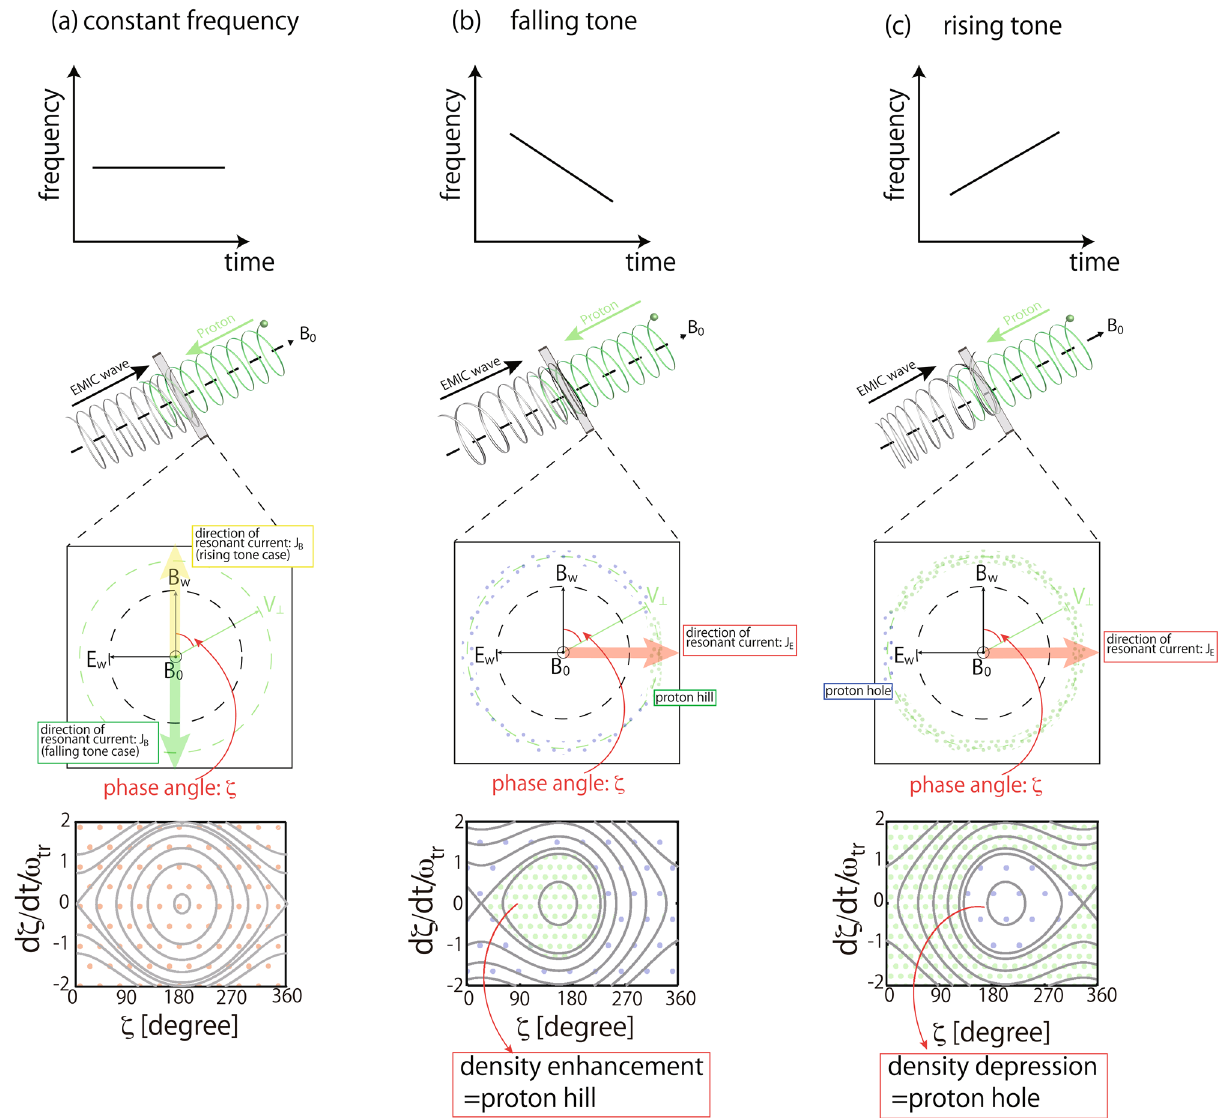
Figure 1. Schematic illustrations of the nonlinear cyclotron interactions of protons with the EMIC waves that have ( a ) constant ( S = 0), ( b ) falling ( S < 0), and ( c ) rising ( S > 0) frequencies. (Created by using Adobe Illustrator 2021, https:// www. adobe. com/ produ cts/ illus trator.